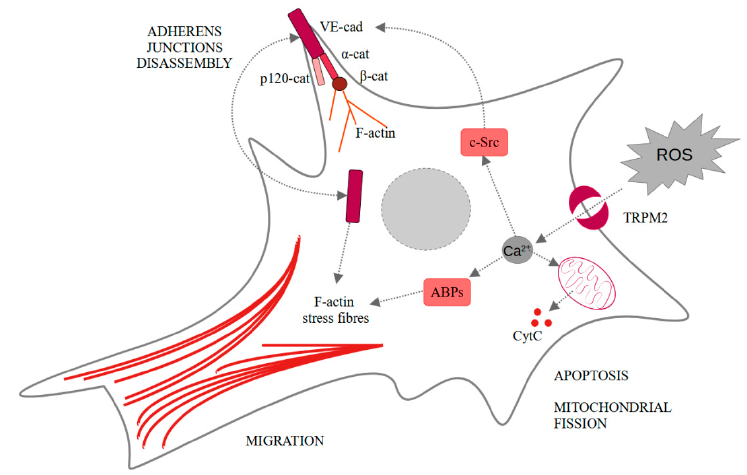
Figure 2. Intracellular changes induced in endothelial cells by the TRPM2-dependent calcium influx. α -cat— α -catenin; β -cat— β -catenin; ABPs—actin-binding proteins; CytC—cytochrome C; F-actin— fibrillar actin; p120-cat—p120-catenin; ROS—reactive oxygen species; TRPM2—transient receptor potential melastatin-like subfamily member 2.